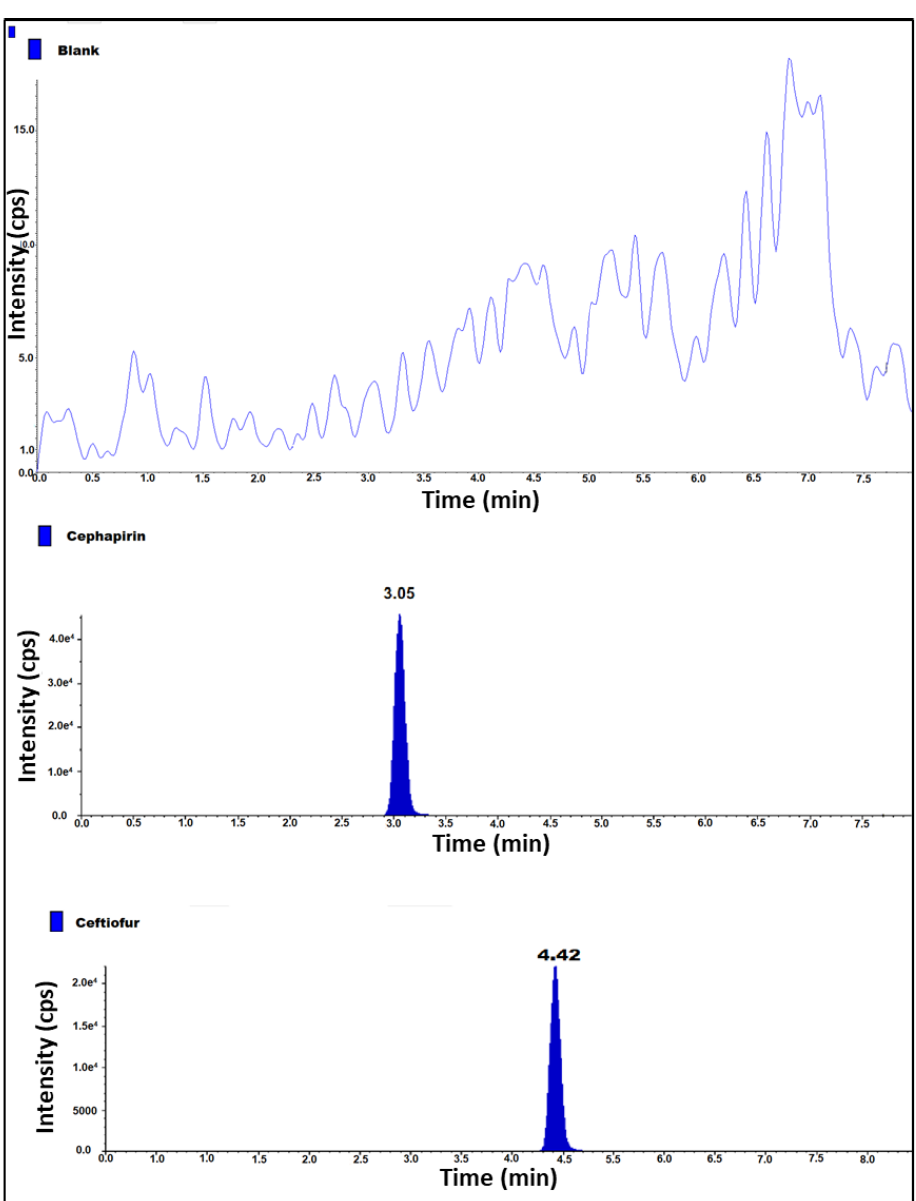
Figure 2. MS/MS chromatogram of blank, cephapirin and ceftiofur standard solution. Table 1. Summary of method validation results.